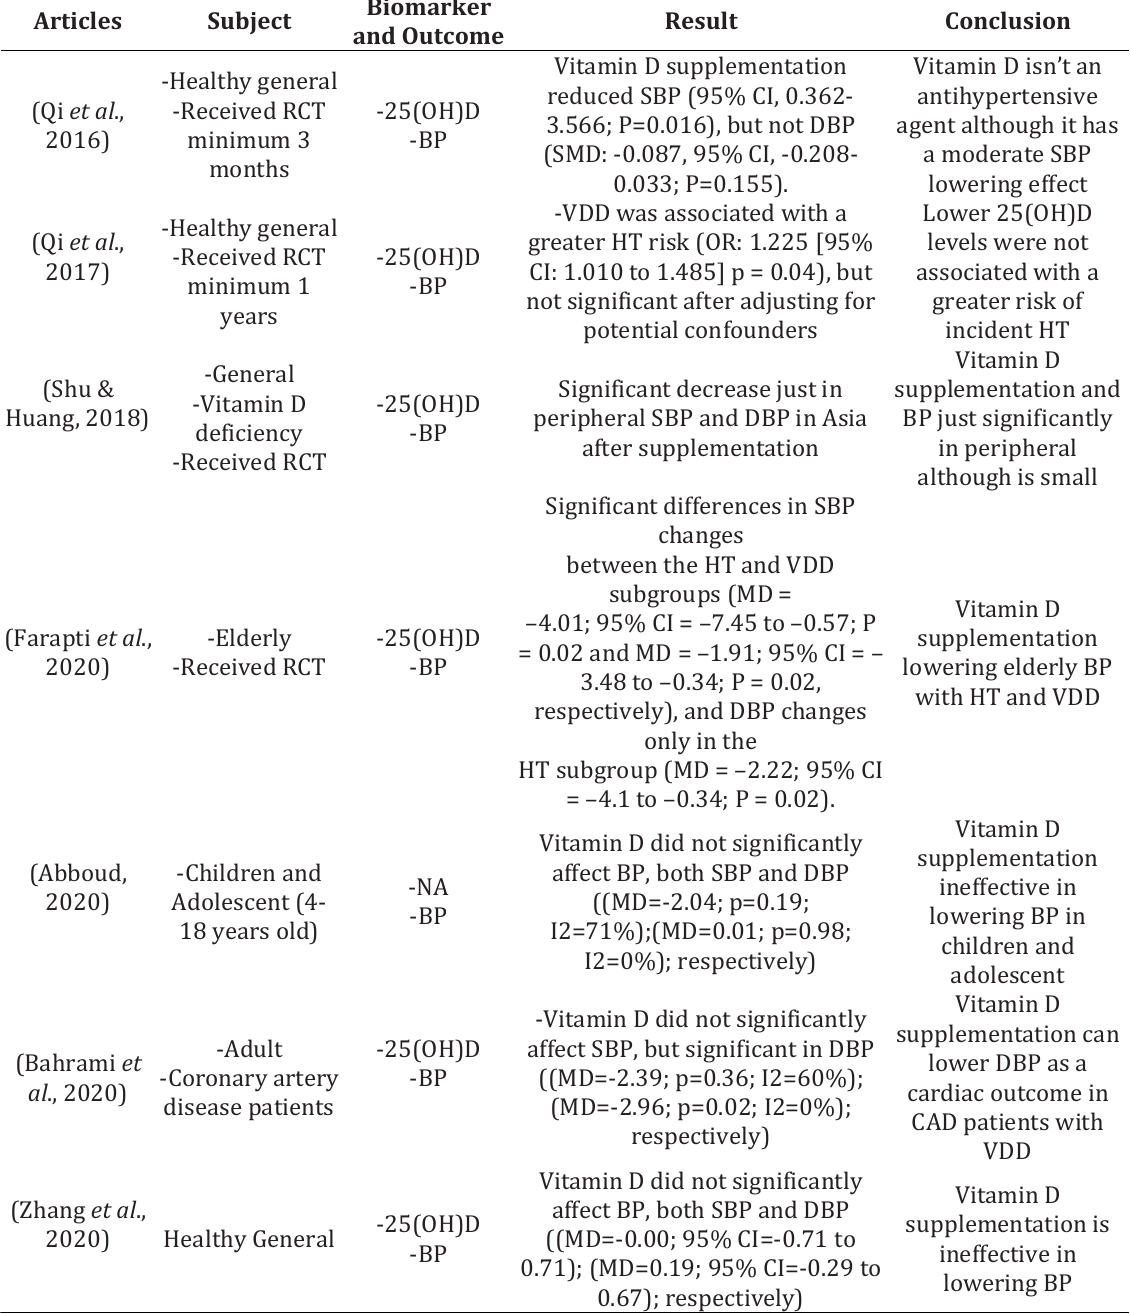
Table Ib. Summary of the Role of Vitamin D on Blood